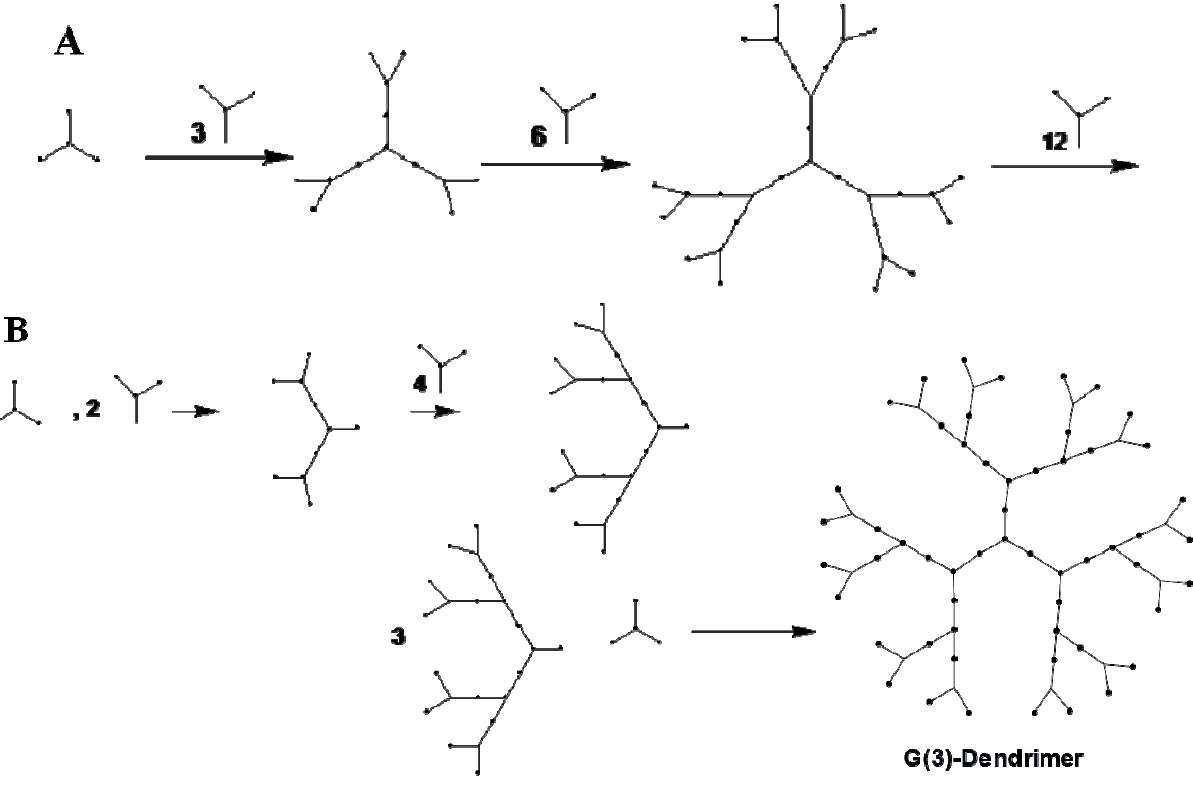
Figure 2. Two common synthetic approaches of dendrimer assembly. Divergent ( A ) amd convergent ( B ) growth